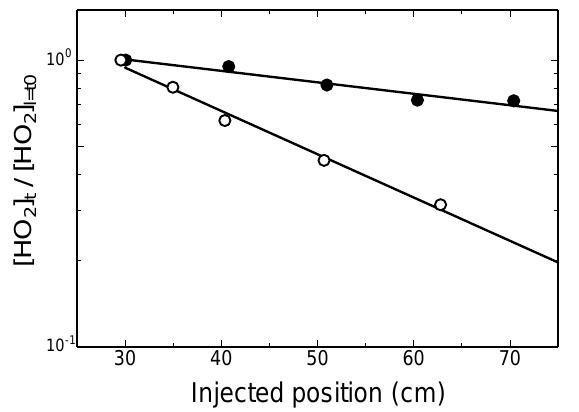
Fig. 3. Plots of first-order decay rates ( k obs ) for HO 2 versus to- tal surface concentrations of T1 particles at 75% RH. The error Figure 3. Plots of first-order decay rates ( k obs ) for HO 2 versus total surface concentrations of T1 3 bars are determined by combining the calculated uncertainties in particles at 75% RH. The error bars are determined by combining the calculated uncertainties in the 4 the slopes from a least-square fit and the decay data, in both the slopes from a least-square fit and the decay data, in both the absence and presence of aerosol 5 absence and presence of aerosol particles. 6